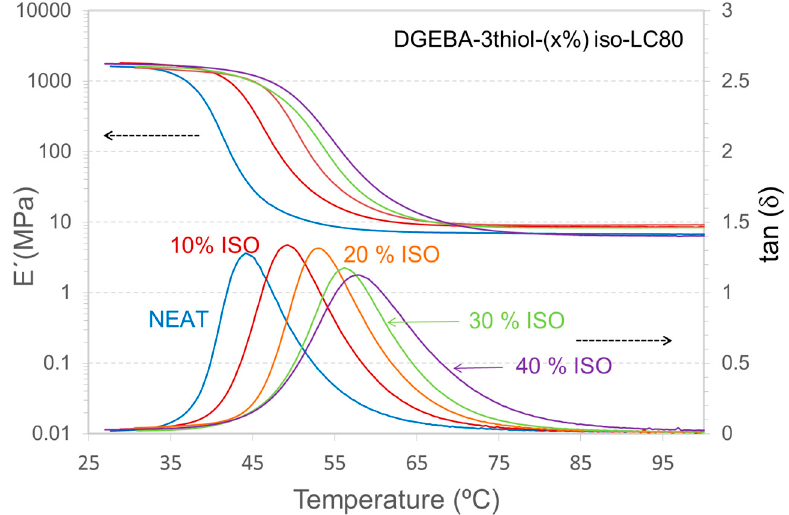
Figure 5. Dynamic-mechanical analyses for the (3thiol) different formulations.